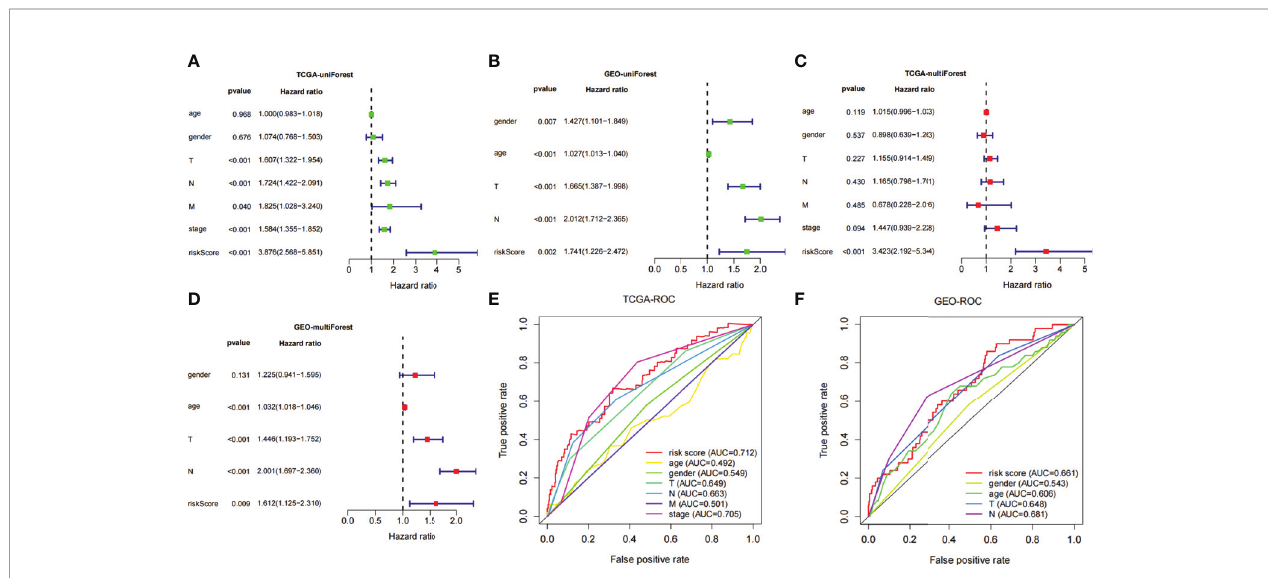
FIGURE 5 | (A, B) Univariate Cox regression analyses of overall survival in TCGA and GEO dataset. (C, D) Multivariate Cox regression analyses of overall survival in TCGA and GEO dataset. (E, F) Comparing the AUCs of the risk scores with other clinical parameters in TCGA and GEO